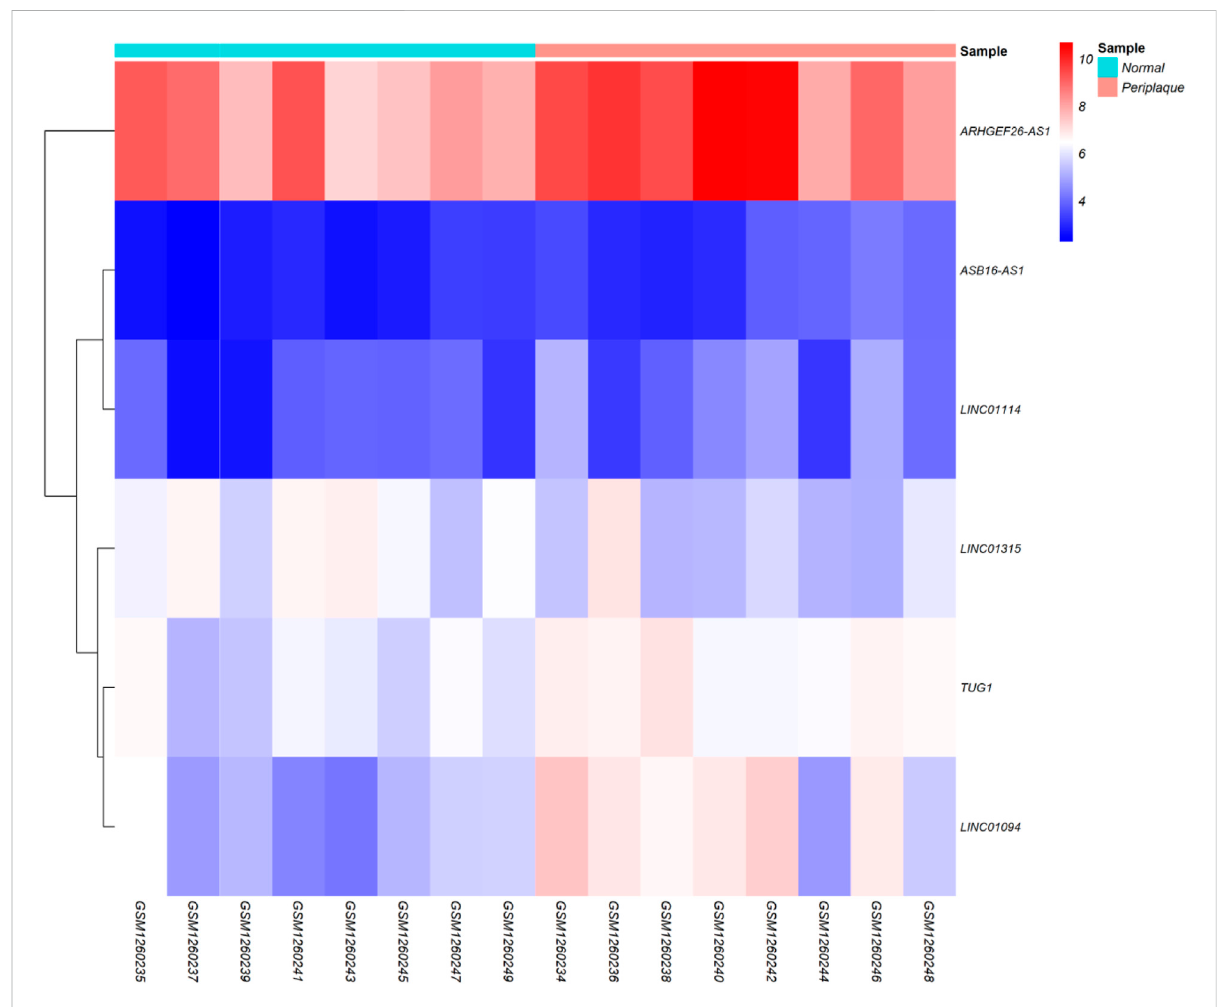
FIGURE 2 Differentially expressed long non-coding RNAs (DElncRNAs) Heatmap. Lowly expressed DElncRNAs are displayed in blue, while those that are highly expressed are displayed in